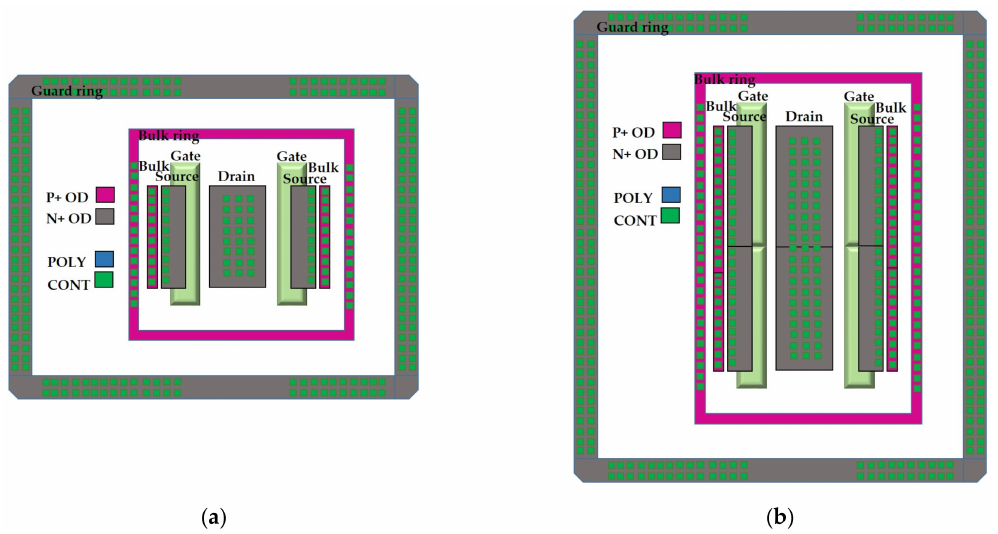
Figure 4. Two-finger layout views of an HV nLDMOS with total channel width (Wtot) being ( a ) 150 µ m, and ( b ) 300 µ